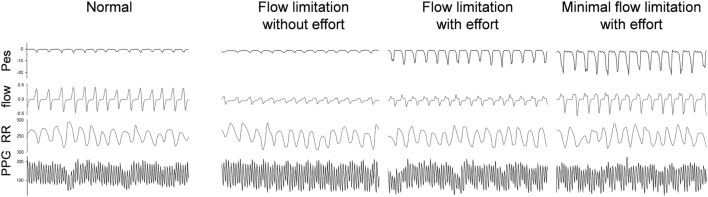
Raw data of a representative subject during stage 2-NREM sleep with different presentations of the simultaneous esophageal manometry (Pes) and the nasal flow pressure recordings. The 90-s tracings from top to bottom were Pes, nasal pressure, RR intervals, photoplethysmography (PPG) signal. The PPG signals vary in relation to the respiratory efforts as do the RR components. High respiratory efforts associated with presence of upper airway resistance syndrome independent of “compensation” to the increased effort or already presence of flow limitation at analysis of the nasal flow curve contour is associated with significant increase in parasympathetic tone.